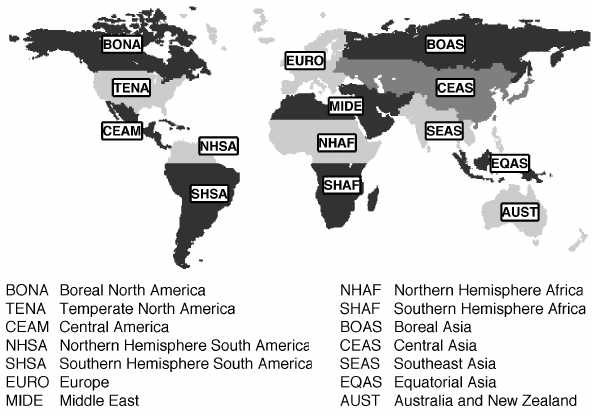
Fig. 7. Map of the 14 regions used in this study, after Giglio et al. (2006) and van der Werf et al. (2006).